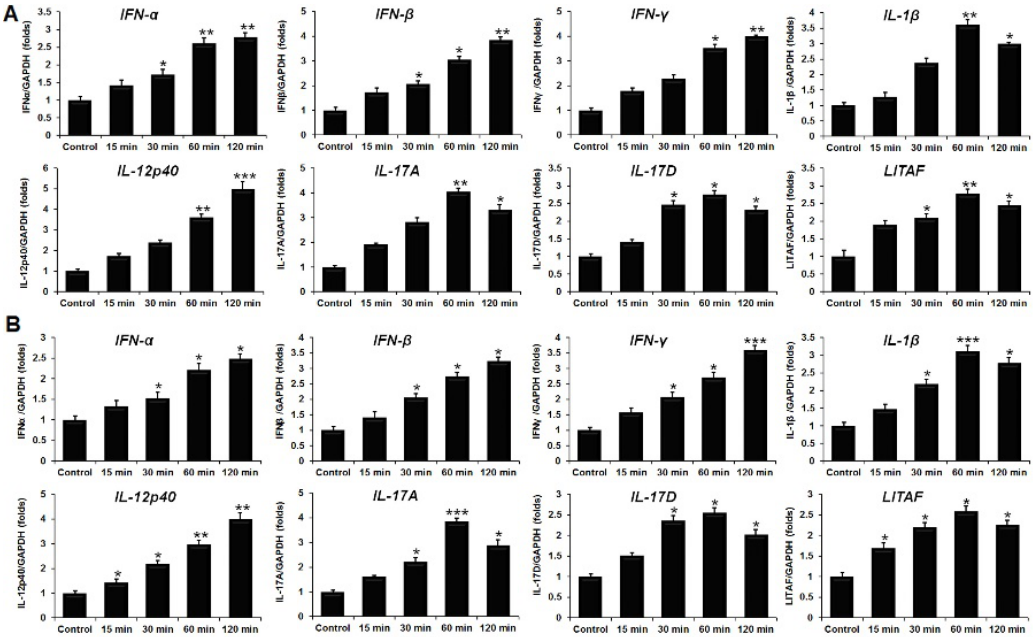
Figure 5. The expression levels of cytokines induced by chicken IL-34 (chIL-34) in HD11 ( A ) and OU2 ( B ) cell lines. Levels are normalized to those of GAPDH. Data are presented as the mean ± SEM ( n = 3) of 3 independent experiments: * p < 0.05, ** p < 0.01, and *** p < 0.001.